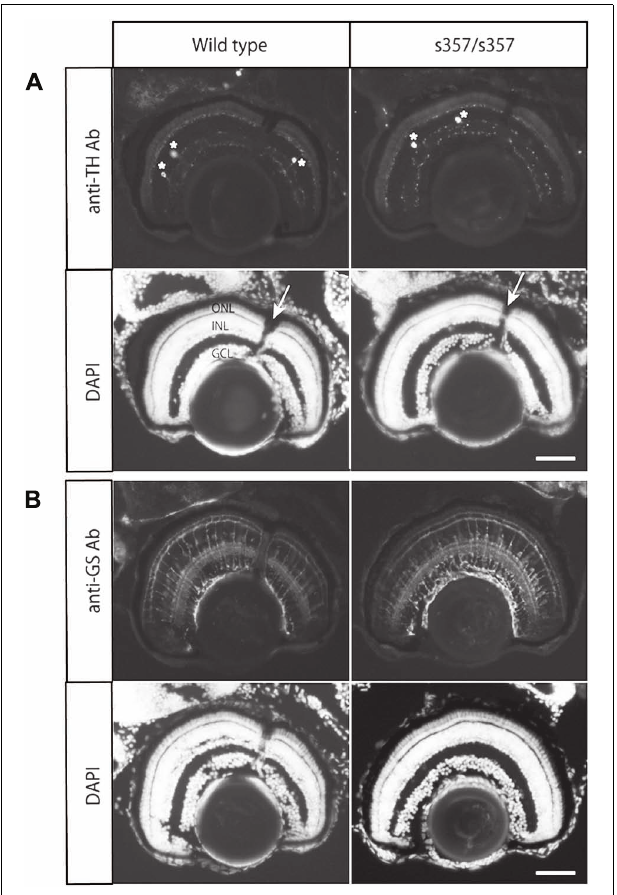
FIGURE 5 | Immunohistochemical analysis ofTH and glutamine synthetase in the retina.(A) Immunostaining with a monoclonal antibody (Ab) againstTH. Cell bodies of theTH-positive cells in the section are shown with asterisks. Arrows in nuclear staininig (DAPI) shows the optic nerve. (B) Immunostaining with anti-glutamine synthetase (GS) antibody. Note that there were no significant difference in the staining intensity and patterns between wild type and the mutant retina. ONL, outer nuclear layer (photoreceptor cell layer); INL, inner nuclear layer; GCL, retinal ganglion cell layer. Scale bar: 50 μ m.